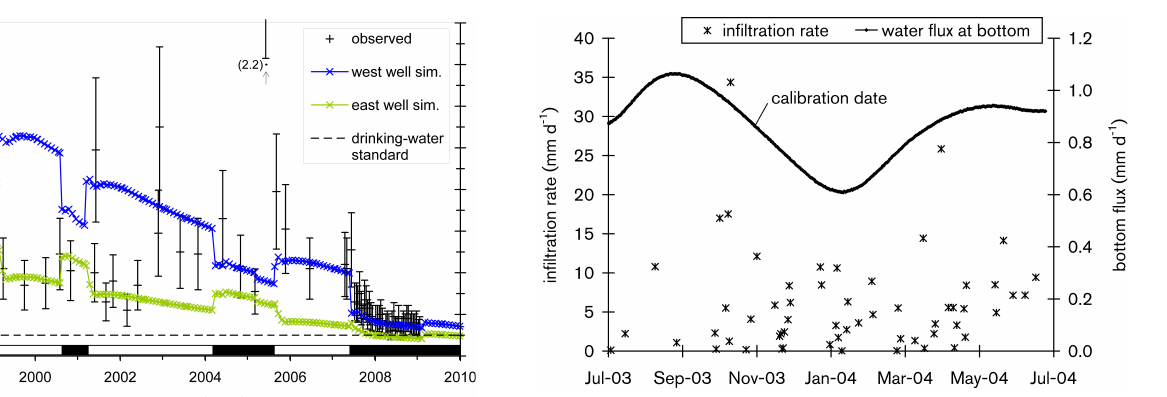
Fig. 6. Simulated and observed concentrations of BAM at the ex- traction wells. The analysis error was ± 35% and is indicated by error bars. Black bar at the bottom of the graph indicates that the wells were running; white bar indicates that they were closed. Note that before 2007, it is unclear whether the observed values were sampled in the western or eastern well. As from 2007, all observed values refer to the western well. The observed peak value in 2005 was characterized as an outlier, according to Dixon’s Q-test. The European drinking water standard is 0.1µgl − 1 for pesticides.